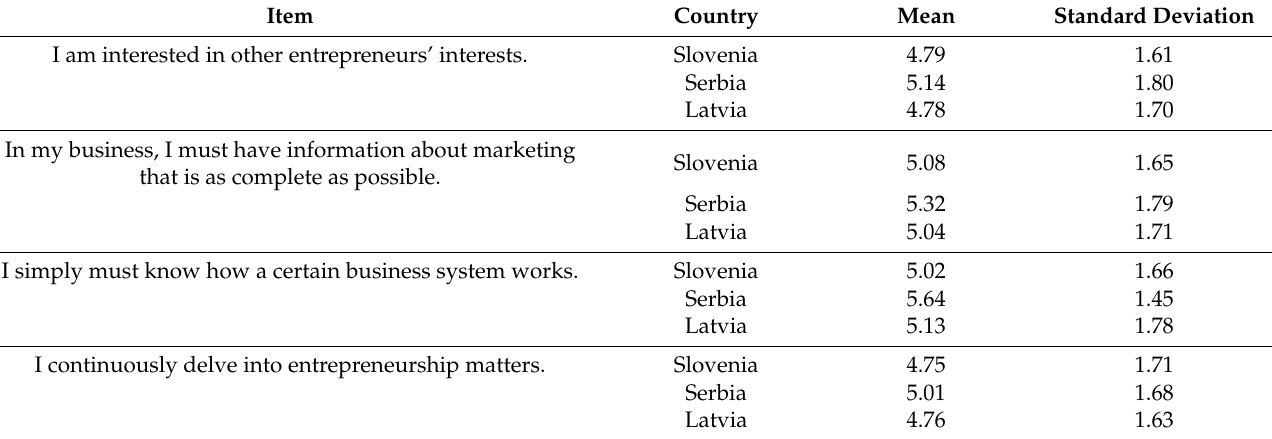
Table A1. Entrepreneurial curiosity items* (Agreement with the statement: 1 = Strongly Disagree, 2 = Moderately Disagree, 3 = Slightly Disagree, 4 = Neither Agree nor Disagree, 5 = Slightly Agree, 6 = Moderately Agree, 7 = Strongly Agree) [15].